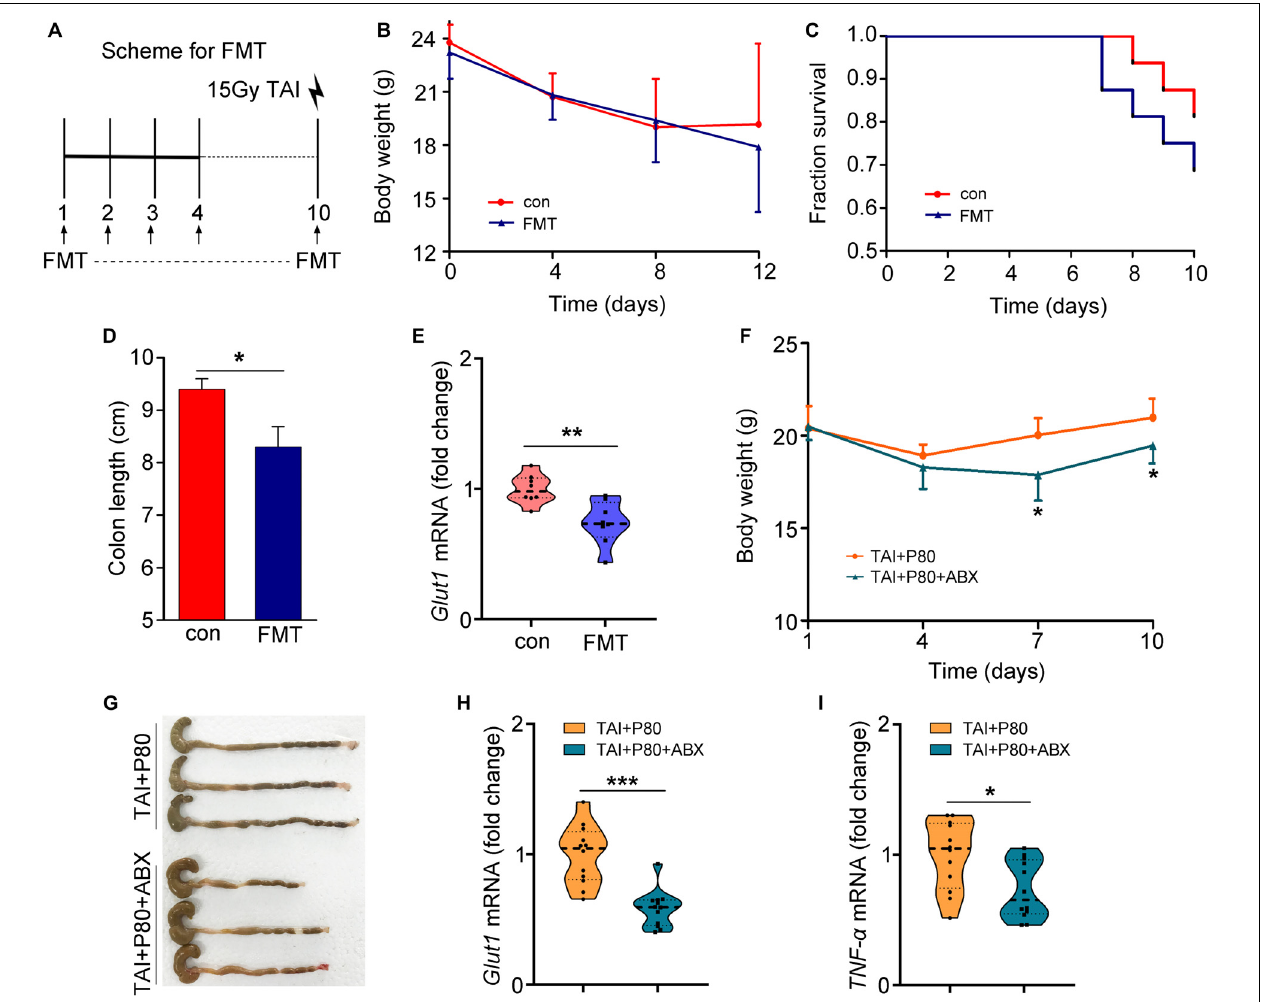
FIGURE 4 | Alteration in the gut microbiota aggravates RIII. (A–E) Mice were separated into two groups randomly. Before 15 Gy γ ray exposure, one cohort was treated with saline as control (named saline-treated FMT), the other was treated with intestinal microbes of P80-challenged mice in saline (named P80-treated FMT). (A) Scheme for FMT. (B) Mice received 10 days of oral gavage with saline or FMT, the body weight was measured after TAI using two-way group ANOVA (* p < 0.05). n = 8 per group. (C) Kaplan–Meier survival analysis of mice was performed after TAI. p = 0.2589 by log-rank test between con and FMT group, n = 8 per group. (D) The length of colon tissues was measured at 15 days after TAI. Statistically significant differences are indicated: * p < 0.05; Student’s t -test, n = 8 per group. (E) The expression level of Glut1 was examined in small intestine tissues by qRT-PCR. Significant differences are indicated: ** p < 0.01; Student’s t -test, n = 8 per group. (F–I) Mice were separated into two groups randomly. Before 12 Gy γ ray exposure, mice were treated with P80 by oral gavage for 7 days, then one cohort was treated with sterile water (named TAI+P80), the other was treated with antibiotic cocktail (named TAI+P80+ABX). (F) Mice received water or ABX treatment, the body weight was measured using two-way group ANOVA (* p < 0.05), n = 12 per group. (G) The length of colon tissues was shown at 15 days after TAI. (H,I) The expression levels of Glut1 (H) and TNF- α (I) in small intestine tissues were examined by qRT-PCR. Significant differences are indicated: * p < 0.05, *** p < 0.001; Student’s t -test, n = 12 per